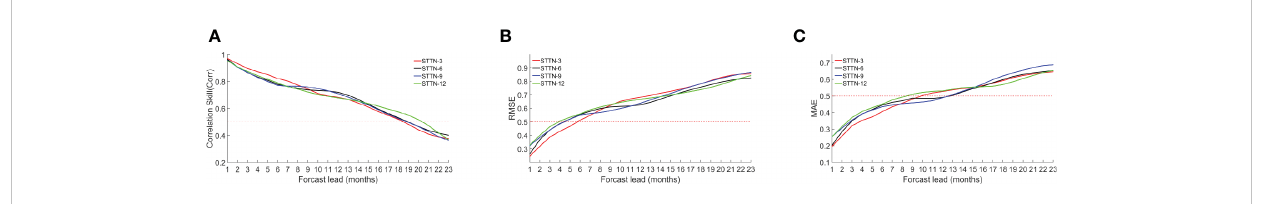
FIGURE 7 Comparison of (A) Corr, (B) RMSE, and (C) MAE between Niño3.4 index predictions and observations for different lengths of input data. The STTN-3, STTN-6, STTN-9, STTN-12 indicate that the length of input data is 3, 6, 9, 12 months,